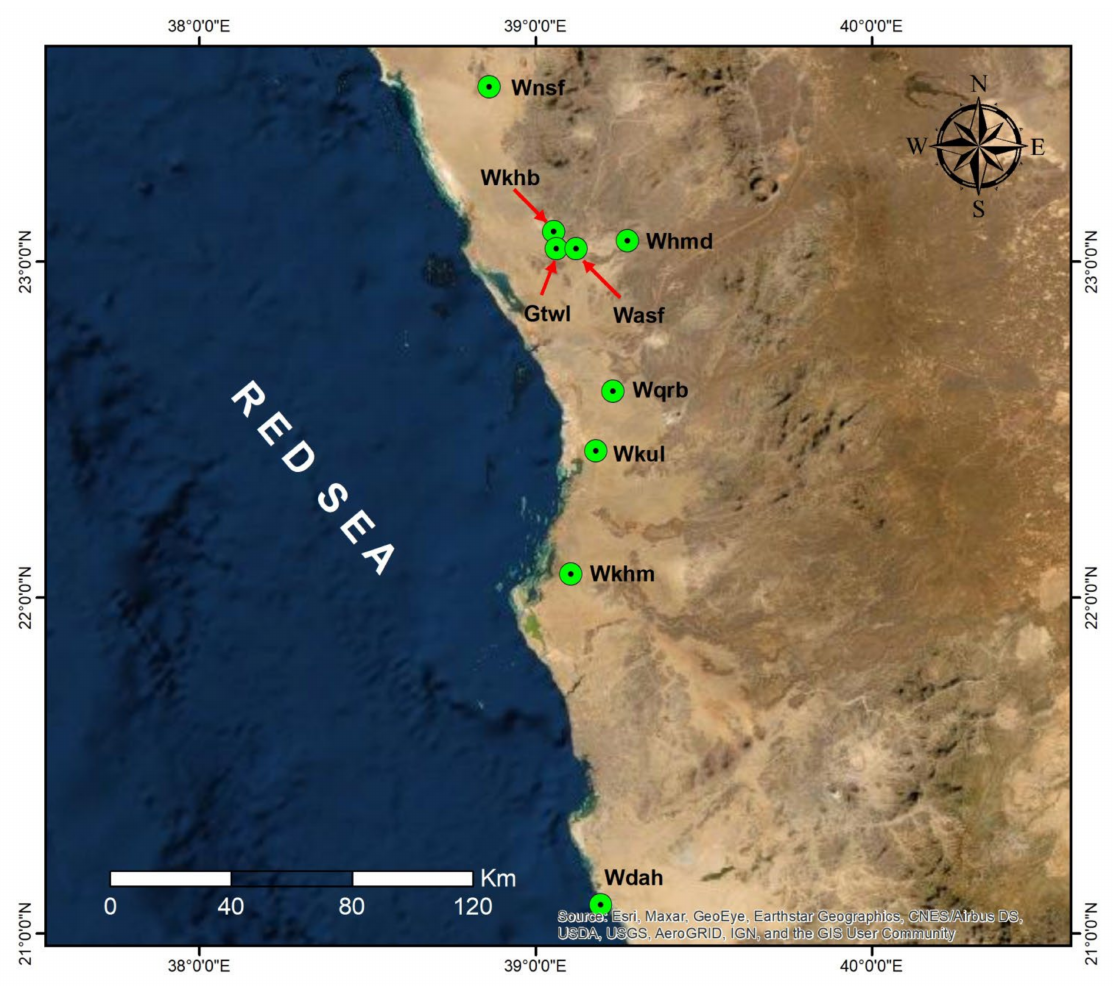
Figure 1. The studied locations of the existing populations of R. epapposum